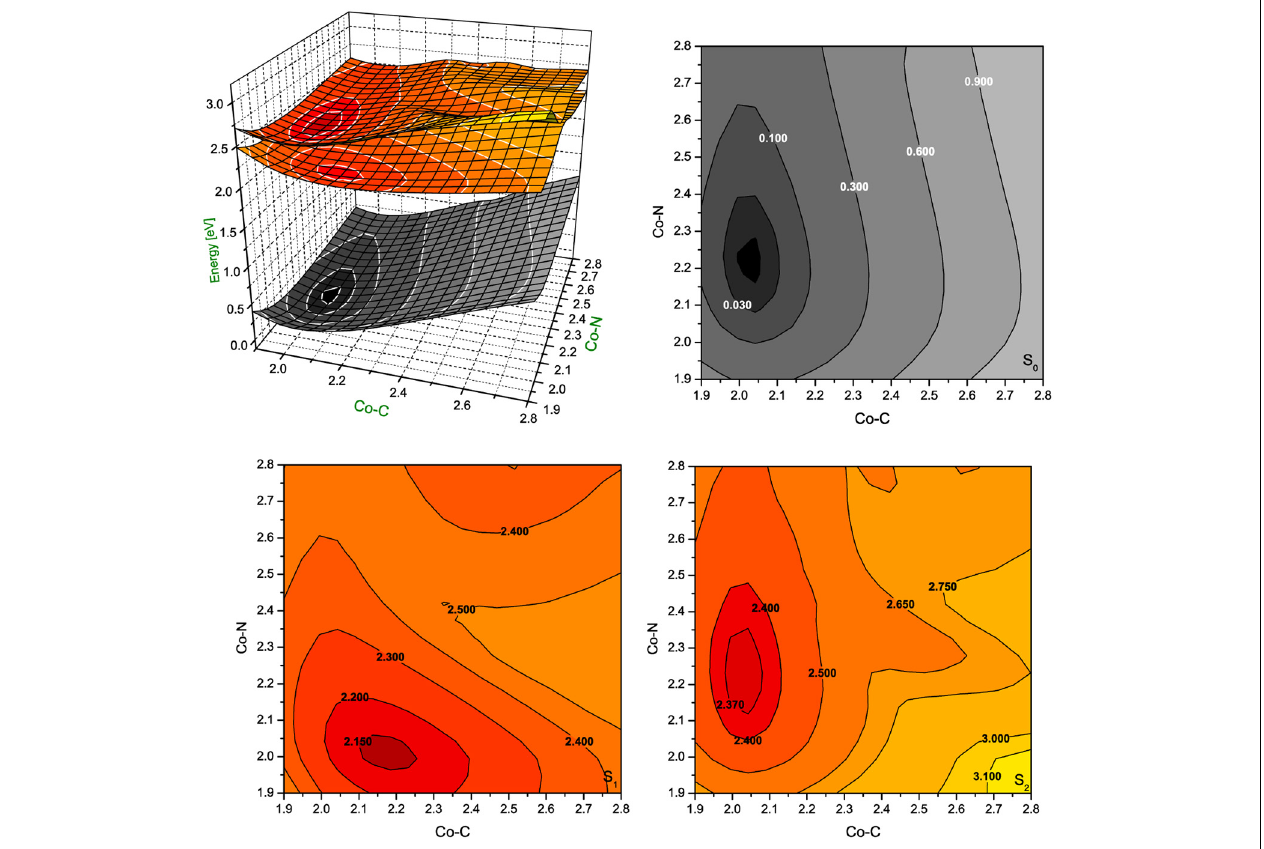
FIGURE 5 | Potential energy surfaces for singlet ground state and two lowest singlet excited states of RibCbl together with their vertical projections plotted as a function of axial bond lengths (expressed in Å) calculated in gas phase with BP86/TZVP.